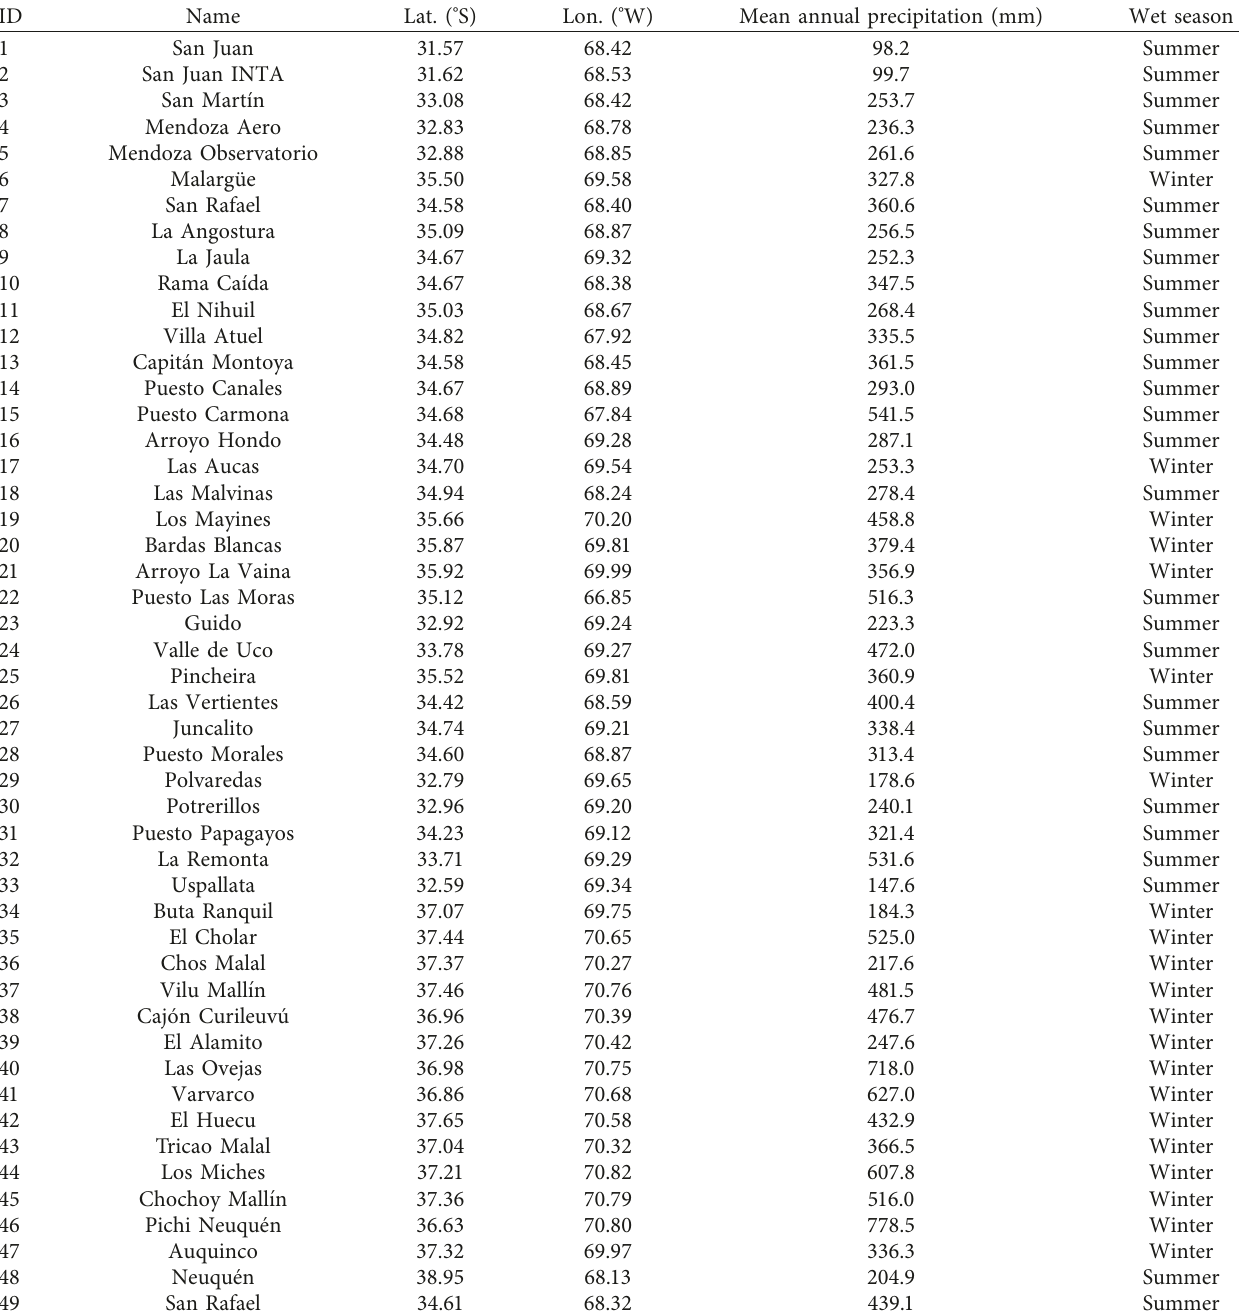
Table 1: Geographic and climatic features of the selected meteorological stations over the period